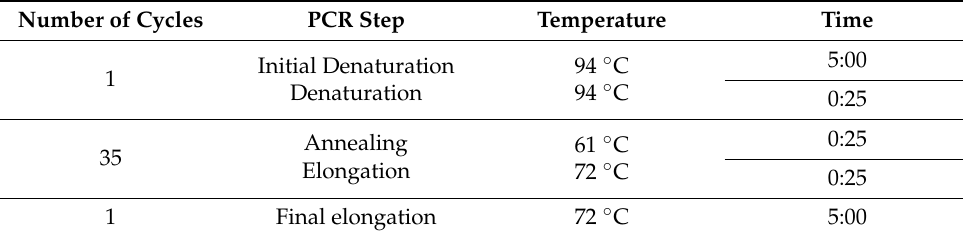
Table 5. PCR reaction conditions for the amplification of a 447 bp fragment encompassing 33 CpG sites in the promoter of the DAT1